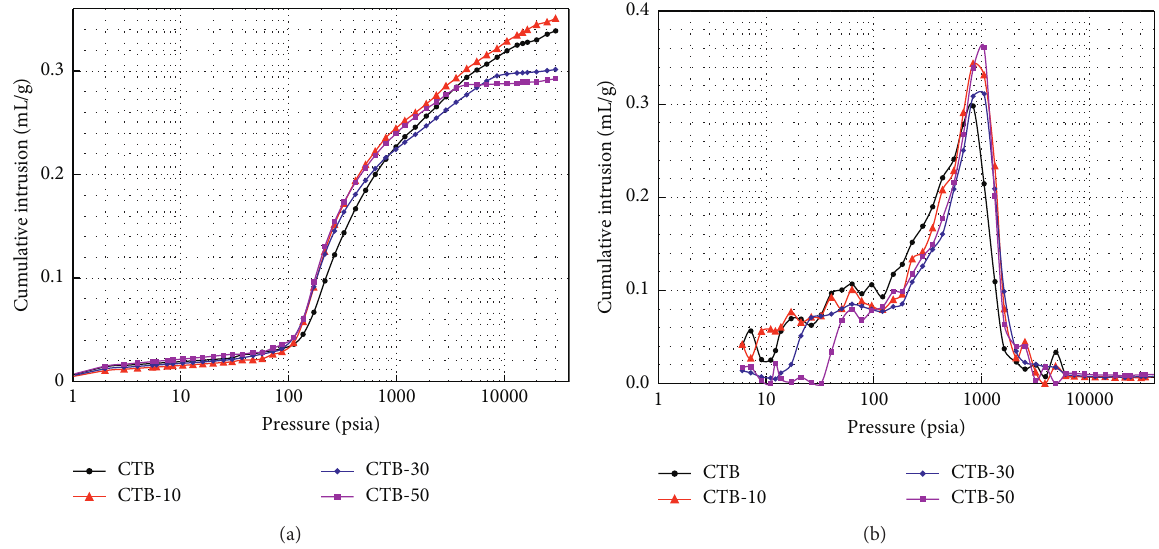
Figure 8: MIP test results for CTB samples curing for 150 days: (a) total pore volume; (b) pore